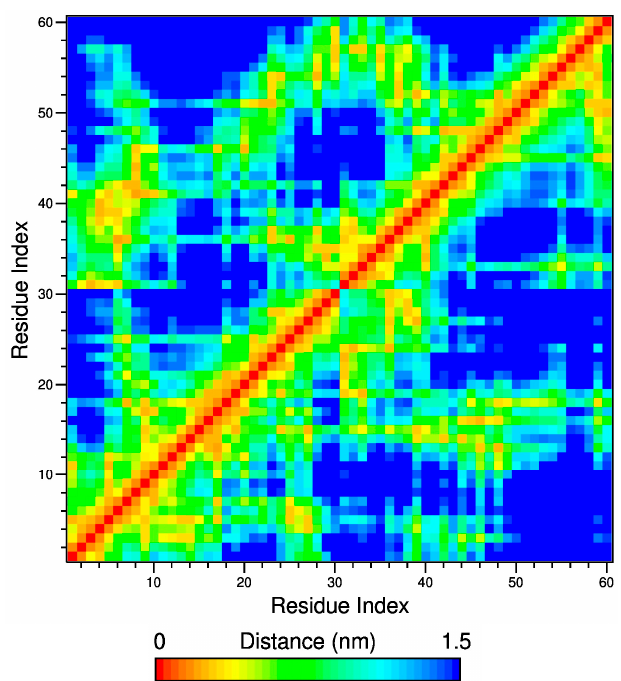
Figure 8. Inter-residues contact map at 323 K in the interval 200–202 ns. The top-left and bottom-right regions across the diagonal refer to atactic and isotactic-rich PNIPAM, respectively. Gels 2017 , 3 , 13